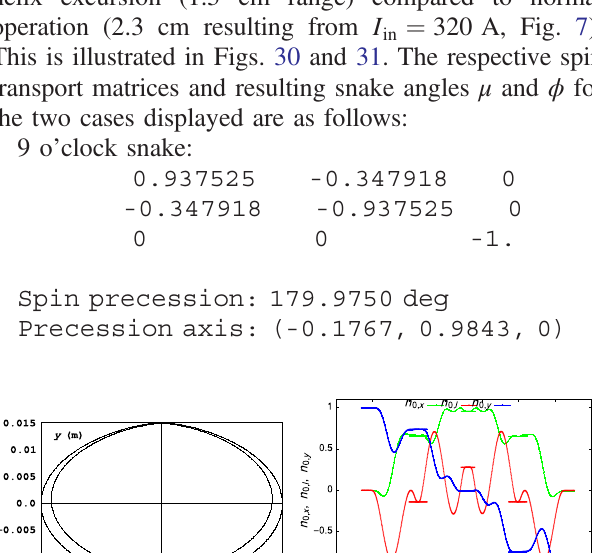
FIG. 30. Along RHIC Yellow 9 o ’ clock snake, case of I 185 A, I ¼ 199 A: ϕ ¼ − 10 ° and μ ¼ 180 °. Left: transverse in projection of the helical motion. Right: spin components, case of initially vertical spin (the small back-forth segments are field map artifacts).